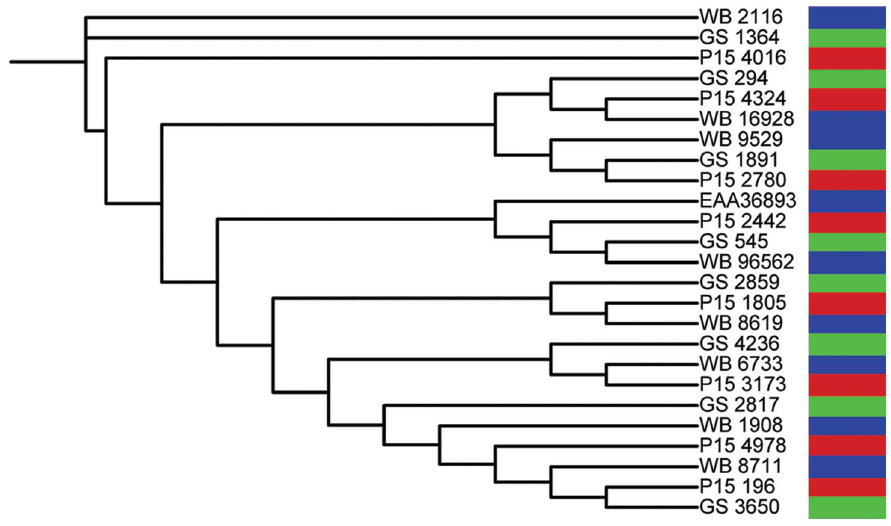
Figure 5. Orthology relationships between Giardia isolates WB, GS and P15 (Assemblages A, B and E, respectively). Phylogenetic tree of Giardia DHHC sequences from the three isolates inferred from ML analyses is depicted. Each isolate is indicated with a different color.